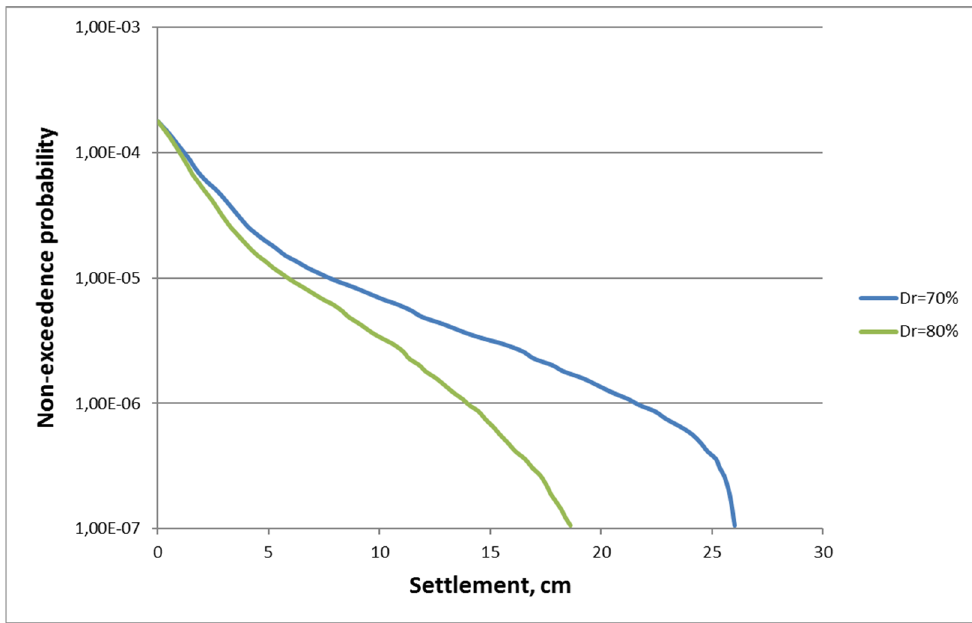
Figure 5. Mean annual rate of non-exceedance for ε v , i at the hazard level λ ∗ , calculated via Equation (5) using the mean annual rate of non-exceedance for FS L shown in Figure 4 for the NPP Paks site.